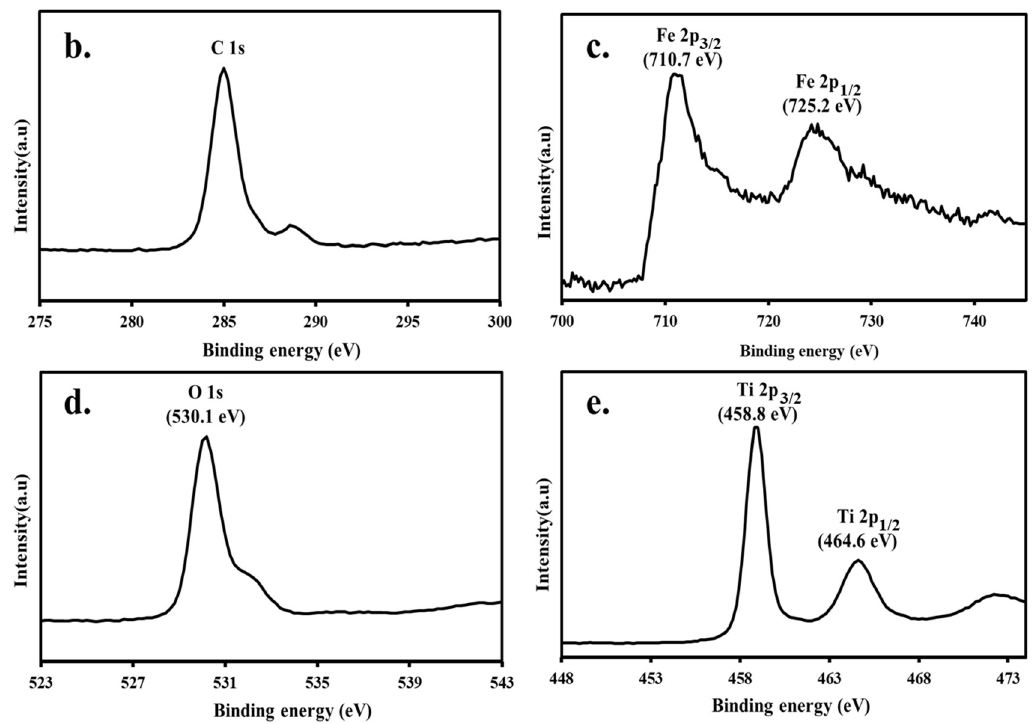
Figure 3. XPS spectra of ( a ) XPS spectrum of Fe/TNAs-0.5, ( b ) C 1s, ( c ) Fe 2p, ( d ) O 1s, and ( e ) Ti 2p. Table 2. Element composition of XPS analyses for TNA, Fe/TNAs-0.2, and Fe/TNAs-0.5. Elements